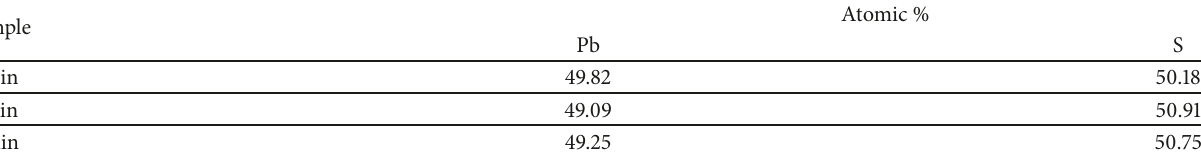
Table 2: Atomic percent of PbS thin films.